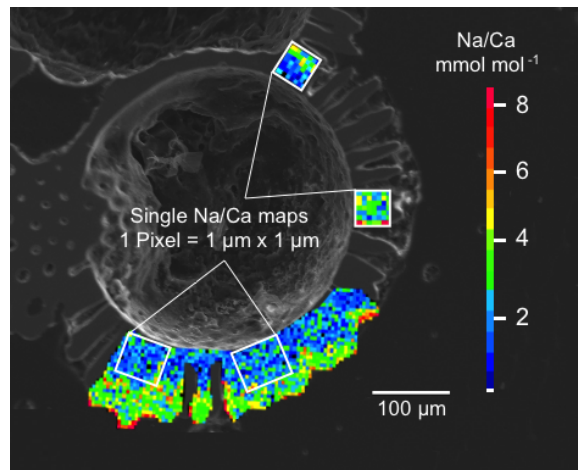
Figure 2. Secondary electron image with overlying maps of Na / Ca values in chamber wall cross sections of cultured T. sacculifer , mea- sured by the electron microprobe. This is an example of single maps within one chamber. One pixel is 1µm × 1µm and the total map sizes vary from 5 to 20µm, depending on chamber wall’s thickness. Averaged Na / Ca maps are used to present results of both salinity and temperature experiments. Na and Ca intensities deviating more than 2 σ from maximum intensities within a map were